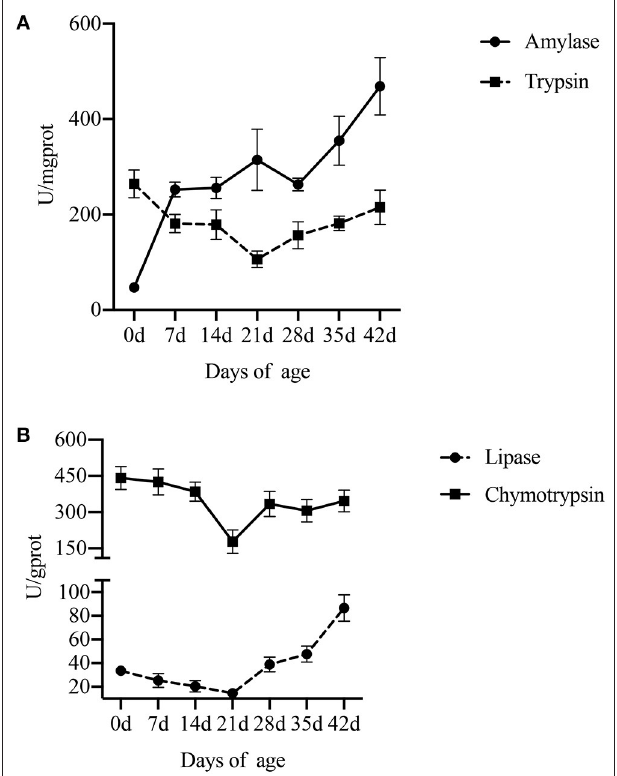
FIGURE 3 | Effect of piglet age on pancreatic digestive enzyme activity. (A) Amylase and trypsin. (B) Lipase and chymotrypsin. Values are expressed as means ±